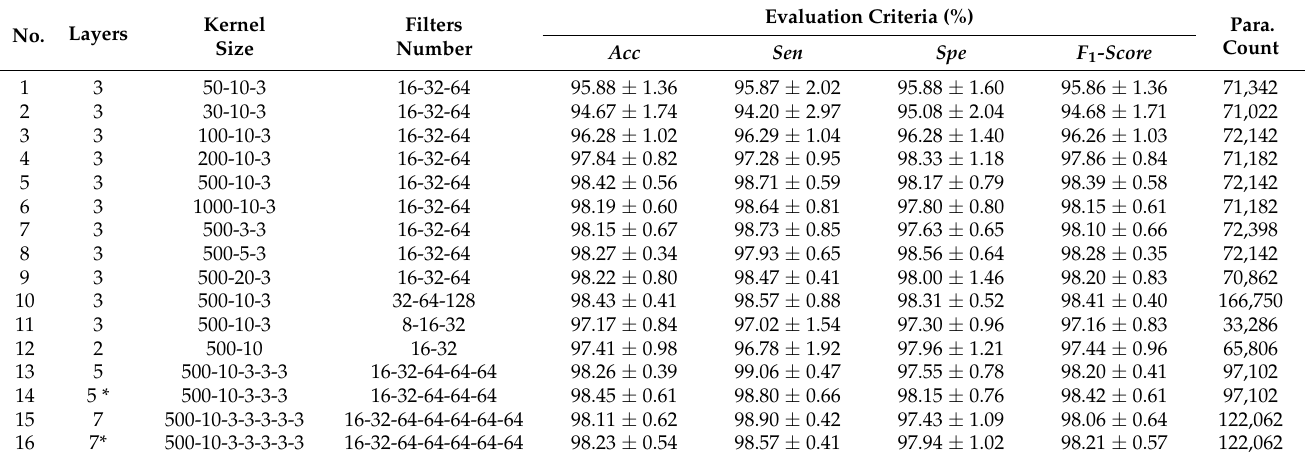
Table 5. The performance of convolutional neural networks with raw signals as input. These convolutional neural networks are the variants of the reference model presented in Figure 5b.